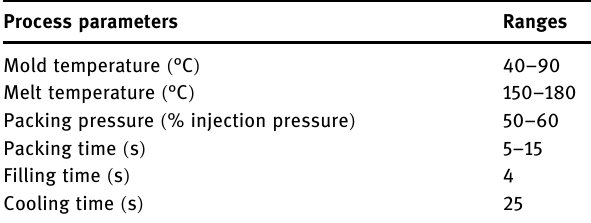
Table 1: Injection molding process